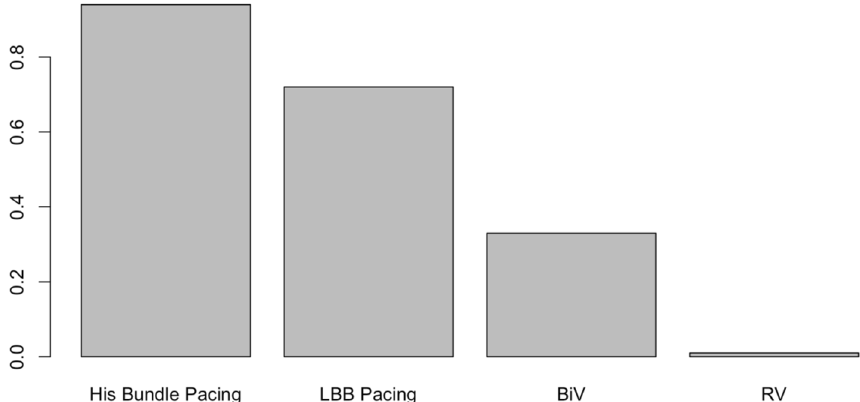
Figure 4. The surface under the cumulative ranking curve (SUCRA) represented overall ranking effect of QRS reduction between pacing types. His bundle pacing showed highest reduction of QRS duration follow by LBB pacing and BiV. Conventional RV apical pacing showed lowest